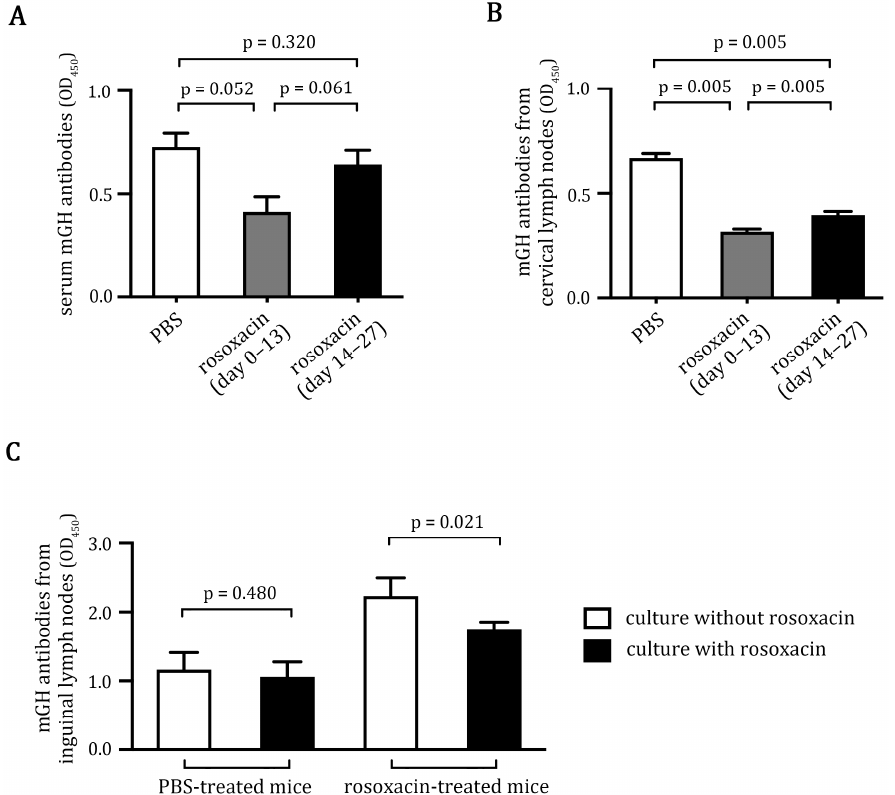
Figure 3. Rosoxacin reduced autoantibody production. ( A ) Anti-mGH antibodies in the sera of EAH mice that received different treatments were determined by an ELISA. ( B ) Lymphocytes isolated from deep cervical lymph nodes of EAH mice that received different treatments were cultured for 72 h. The production of anti-mGH antibodies by the lymphocytes were determined by an ELISA. ( C ) Lymphocytes isolated from inguinal lymph nodes of EAH mice that received different treatments were cultured for 72 h with (filled bars) or without (open bars) rosoxacin. The production of anti-mGH antibodies by the lymphocytes was determined by an ELISA.